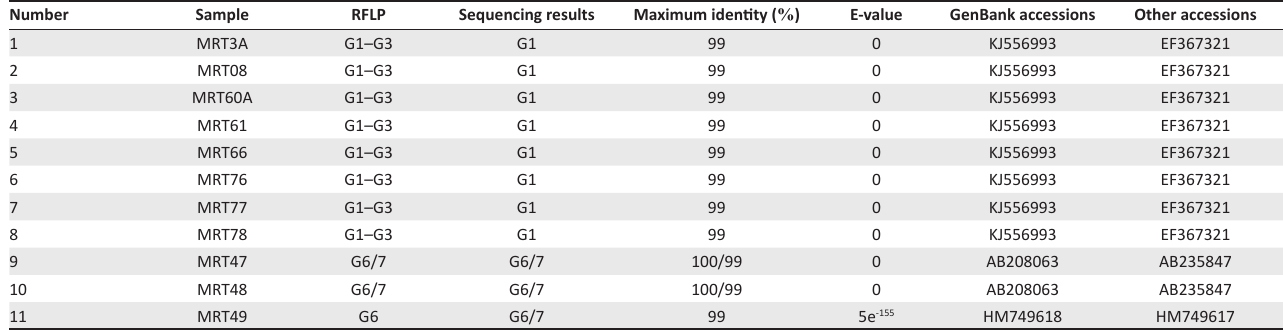
FIGURE 2: A 1.5 % agarose gel showing Echinococcus granulosus NADH 1 gene nested PCR analysis results. TABLE 2: Comparison of test sequences with those from the GenBank. Number Sample RFLP